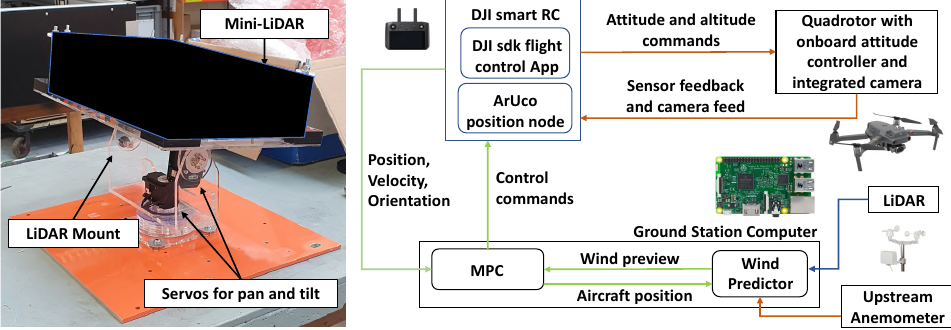
Figure 4. LiDAR on its scanning mount ( left ) and the proposed Quadrotor flight-test platform architecture ( right